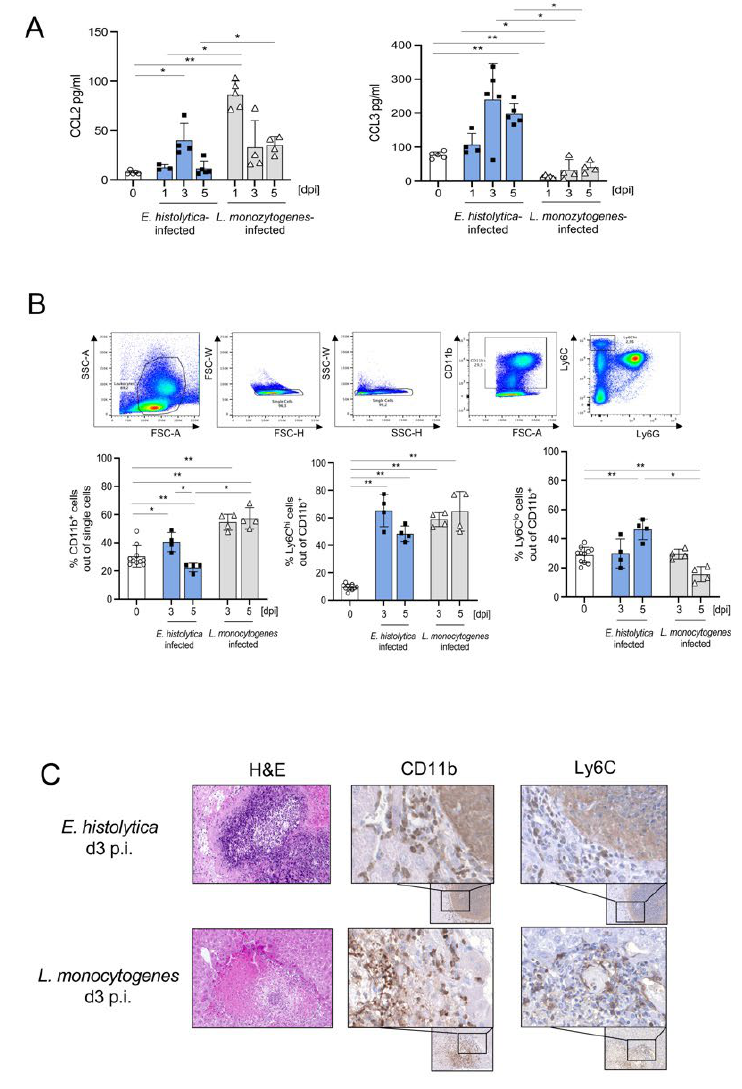
Figure 1. Recruitment of CD11b + Ly6C hi and Ly6C lo monocytes to the liver during infection with E. histolytica and L. monocytogenes , and protective properties of Ly6C hi monocytes against E. histolytica infection. ( A ) Expression of CCL2 and CCL3 in liver lysates after intrahepatic E. histolytica (2 × 10 5 ) and systemic L. monocytogenes (2 × 10 4 ) infection, measured in a multiplex cytokine assay. ( B ) Gating scheme and percentages of CD11b + , CD11b + Ly6C hi , and Ly6C lo monocytes in the liver following E. histolytica or L. monocytogenes infection. ( C ) Liver sections from E. histolytica - and L. monocytogenes - infected mice were stained with H&E, anti-CD11b (EPR1344), and anti-Ly6C (ER-MP20) on day 3 p.i. ( A – C ) One representative experiment of three is shown. (* p < 0.05; ** p < 0.01; Mann-Whitney U test). To determine monocyte recruitment, we isolated leukocytes from infected livers and measured the percentage of CD11b + Ly6C hi and CD11b + Ly6C lo monocytes by flow cytome- try. At d3 p.i., the CD11b + Ly6C hi monocyte populations increased in both infection models, whereas the CD11b + Ly6C lo monocyte population increased only following E. histolytica infection (Figure 1B; absolute numbers see Figure S1B,C). Staining of paraffin-embedded liver sections from both models (d3p.i.) with hematoxylin and eosin (H&E), anti-CD11b, and anti-Ly6C revealed accumulation of CD11b + and Ly6C + cells in a dense margin around the central amebic abscess (Figure 1C) while CD11b + and Ly6C + cells accumulated in the center of typical L. monocytogenes -induced granulomas (Figure 1C; controls see Figure